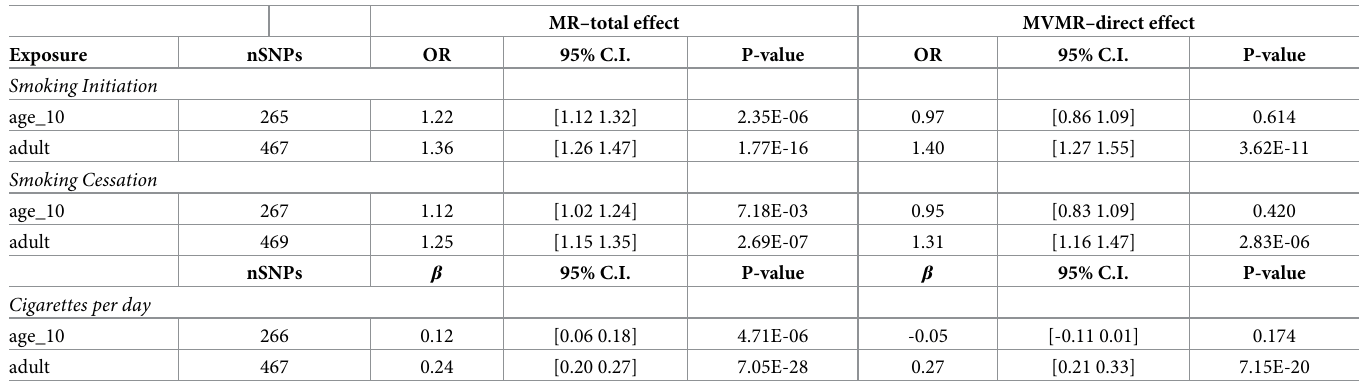
Table 5. Univariable and multivariable estimates for effect of child and adulthood BMI liability on smoking behaviour.